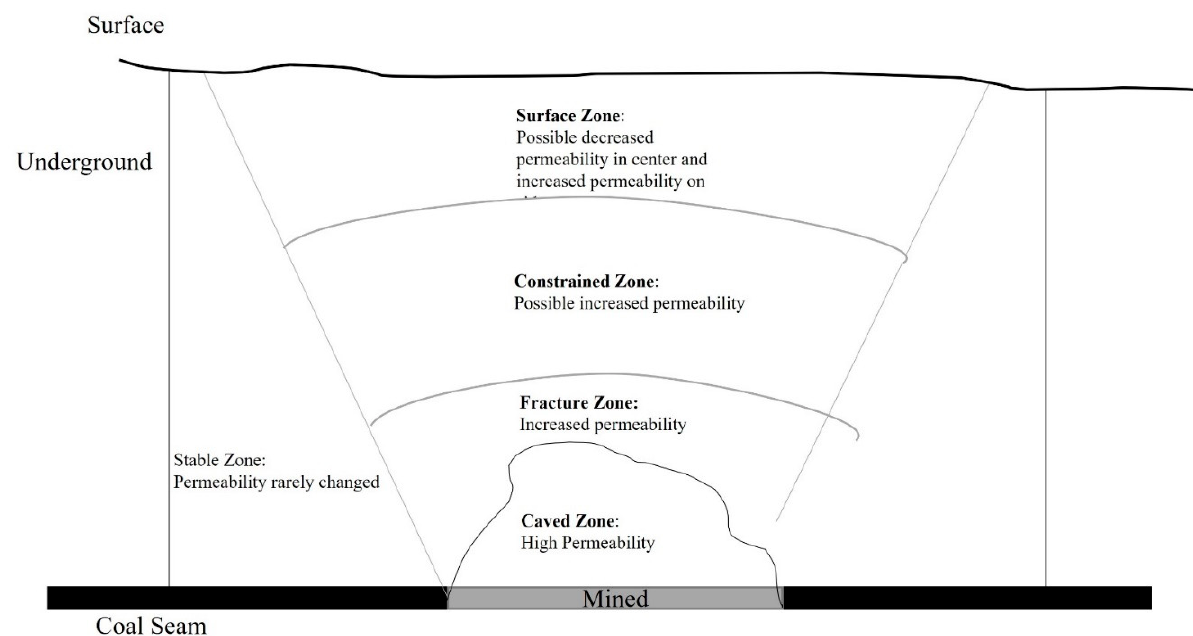
Figure 5. Schematic diagram of hydrogeological model for mined coal seam area, after [35].